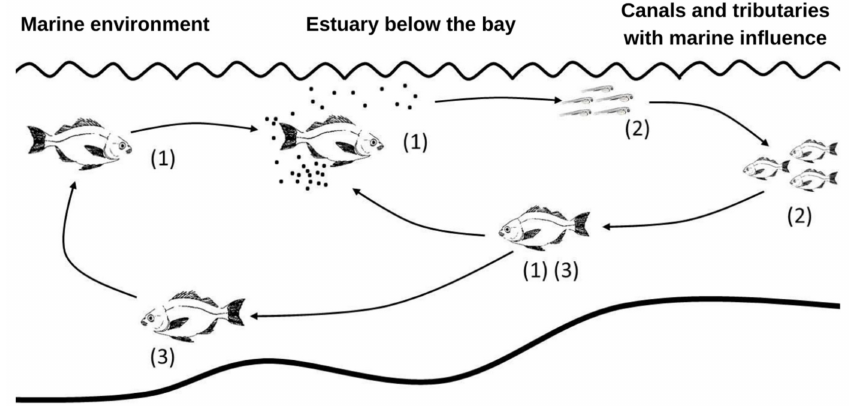
Figure 8. Genyatremus luteus life cycle. (1) Adults in the lower and bay and eggs dispersal; (2) larvae enter the estuary until juvenile stage; (3) pre-adults join the adult population, living in favorable areas until the spawning time of the